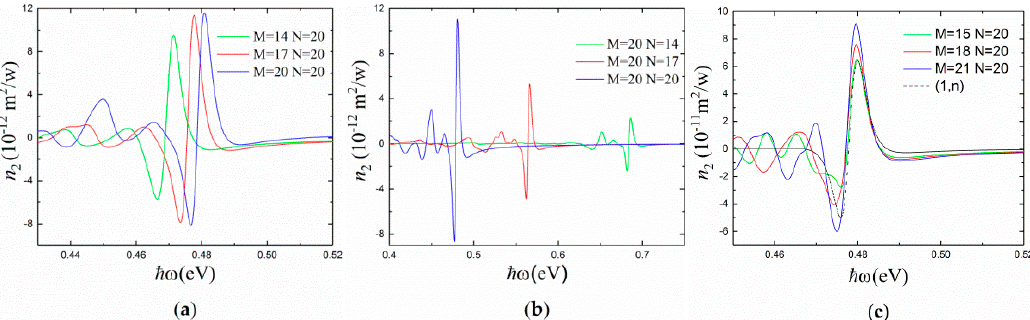
Figure 4. Nonlinear refraction spectra for different-sized RGQDs. ( a ) Non-3 M 0 sized RGQDs with the sizes M = 14, 17, 20, and fixed N = 20. ( b ) Non-3 M 0 sized RGQDs with the sizes N = 14, 17, 20, and fixed M = 20. ( c ) 3 M 0 sized RGQDs with the sizes M = 15, 18, 21, and fixed N = 20. The dashed line is the contribution from the transitions between (1, n ) when M = 21 and N = 20.